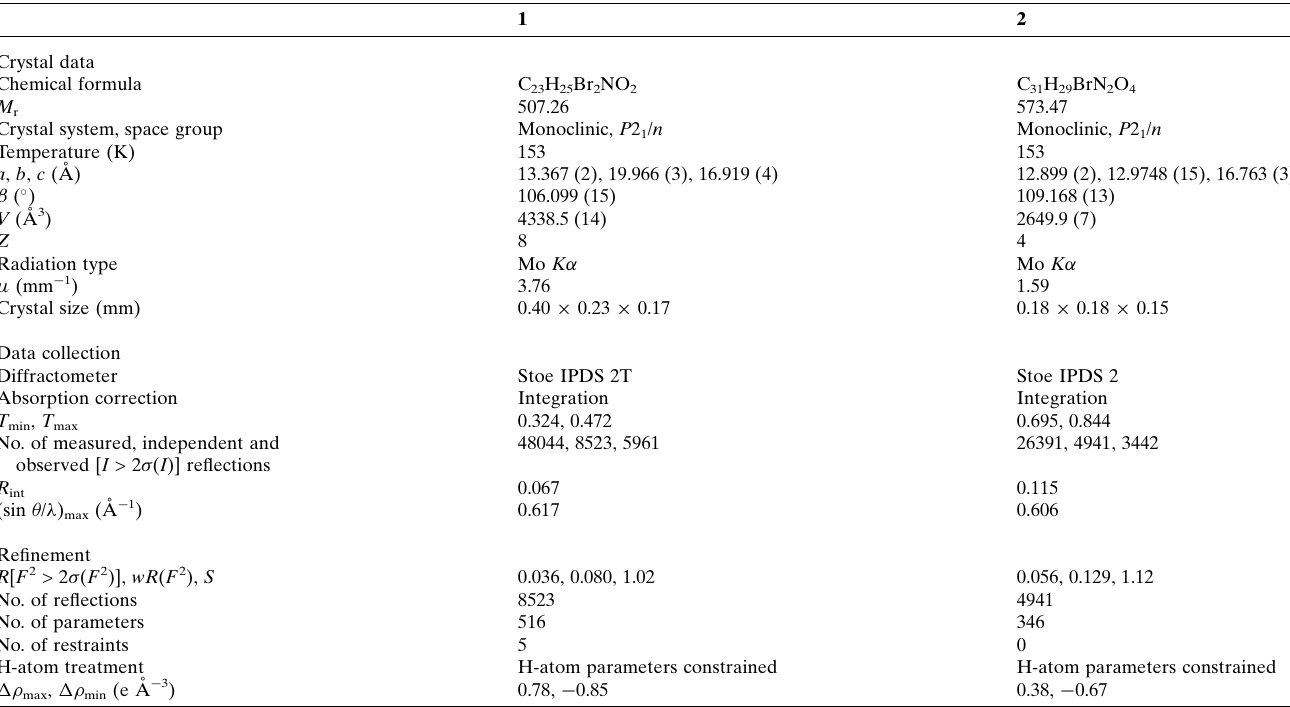
Table 4 Experimental details.